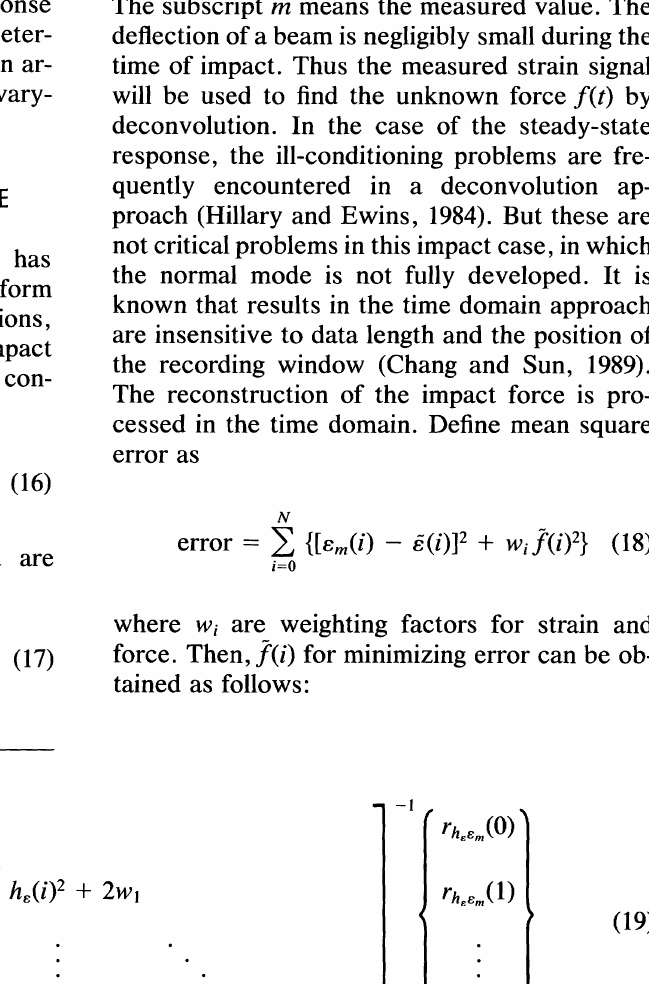
FIGURE 4 Reflection of the strain wave at fixed